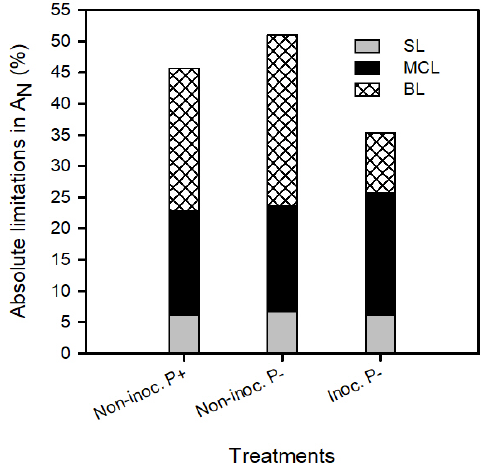
Figure 3. Quantitative analysis of absolute limitations in photosynthesis (A N ) of strawberry plants fertilized with BNM medium without phosphorus (P − ) or with BNM medium supplemented with an insoluble phosphorus form (P+) and subjected to two inoculation treatments after 120 days. SL, stomatal; MCL, mesophyll; BL, biochemical limitations. These results were linked by g m and V c,max responses; thus, the highest g m values were recorded in plants that were inoculated and fertilized with insoluble phosphorus (GLM: Inoc. x Fert., p < 0.01; Figure 4A). Additionally, V c,max values showed a similar trend, alt- hough inoculated plants grown without phosphorus addition also showed significantly higher values than their non-biofertilized counterparts (GLM: Inoc., p < 0.01; Figure 4B).